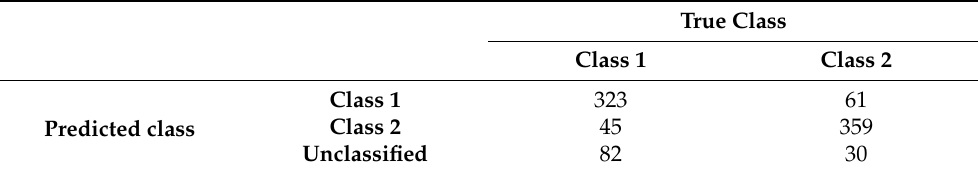
Table 9. Total confusion matrix of 10-fold cross-validation of classification results with the GRS with 90 samples of training data using attributes 4, 6, and 7 of the Raisin dataset.